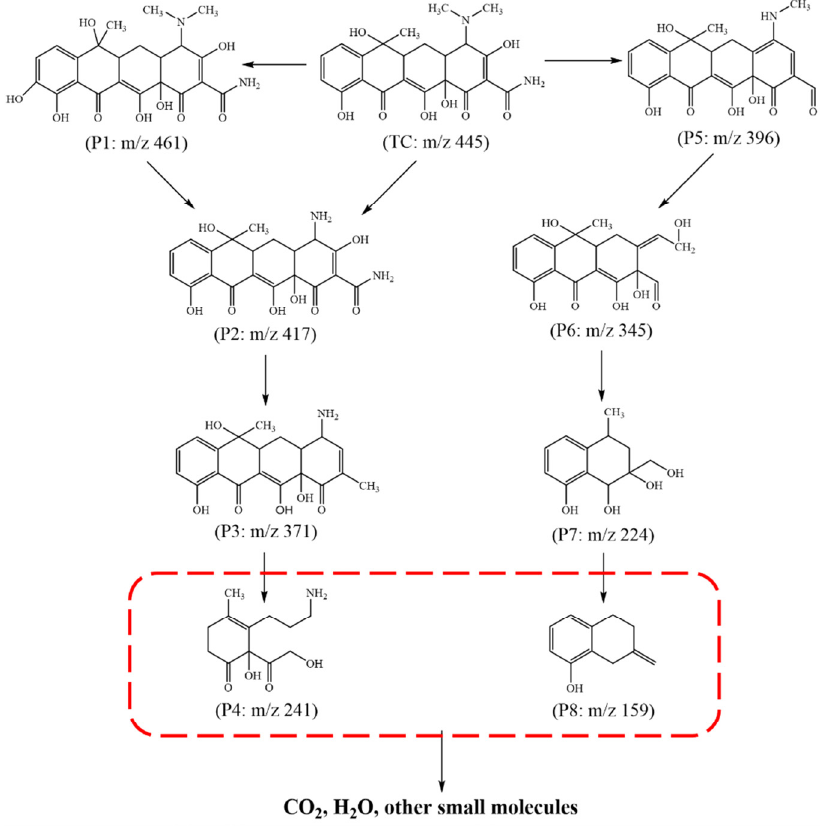
Figure 8. The proposed photocatalytic degradation pathway of TC.